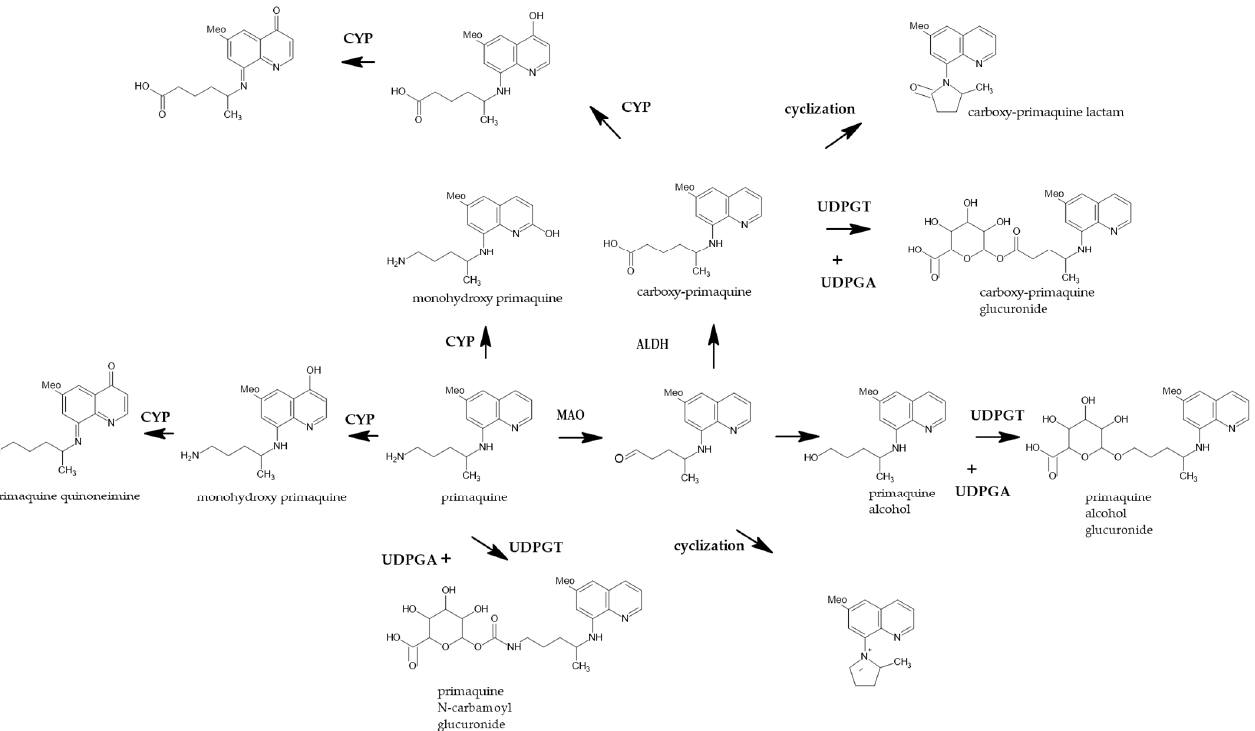
Figure 1. Putative pathways of PQ metabolism in human hepatocyte. ALDH, aldehyde dehydrogenase; CYP, cytochrome P450 (mainly, CYP2D6); UDPGA, Uridine-diphosphate-glucuronic acid; UDPGT, Uridine-diphosphate glucuronosyltransferase. (Adapted from ref [13], Copyright © Fasinu et al. 2016).